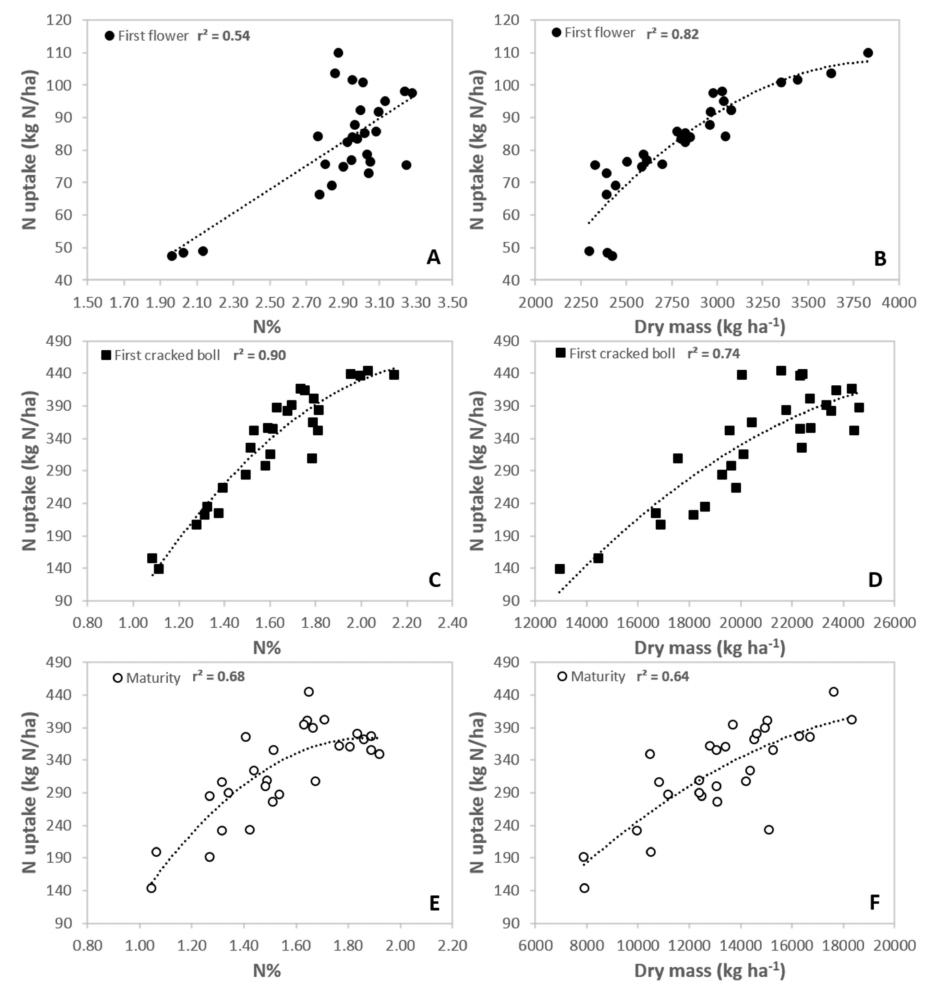
Figure 7. Relationships between N uptake and plant nitrogen concentration (N%) and crop dry mass at first flower ( A , B , respectively), first cracked boll ( C , D ) and maturity ( E , F